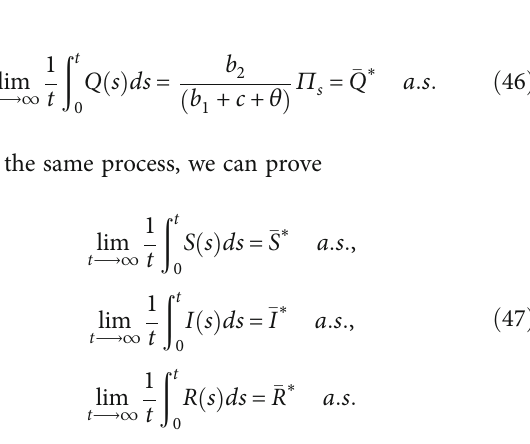
Table 1 and the noise values: σ